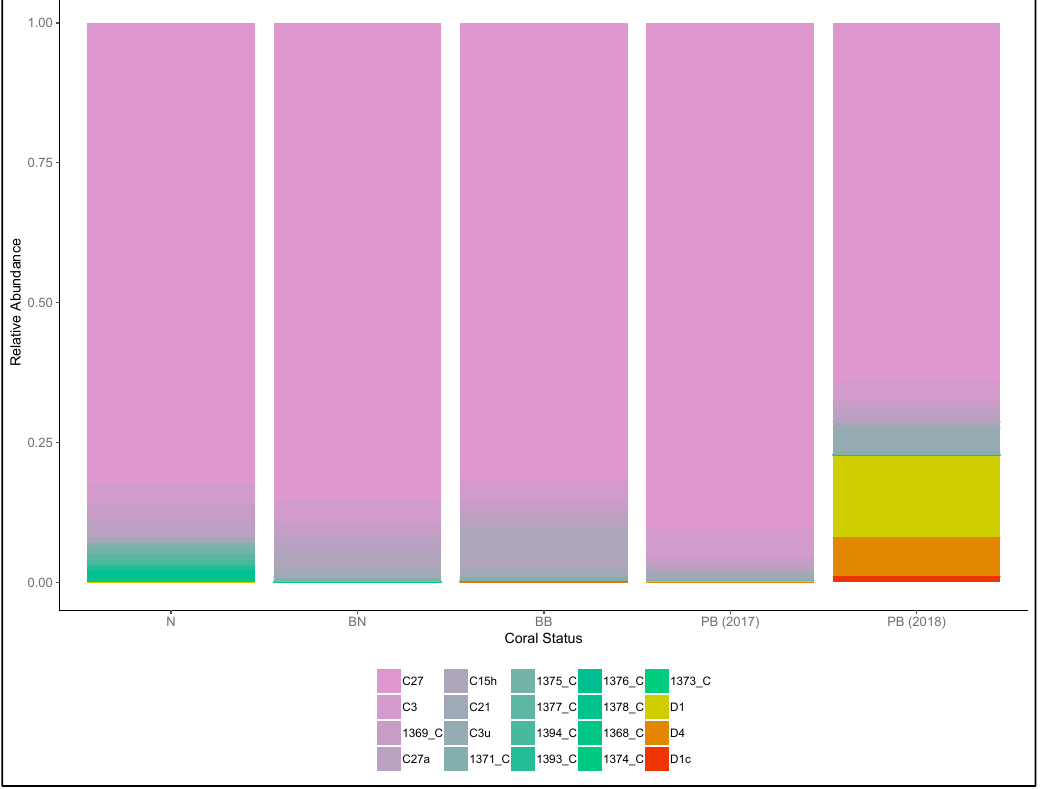
Figure 3. Diversity and relative abundances of Symbiodiniaceae types among the five different coral groups (N: normal colonies in 2016, BN: normal portions of the bleached colonies in 2016, BB: bleached portions of the bleached colonies in 2016, PB (2017): post-bleaching colonies in 2017, PB (2018): post-bleaching colonies in 2018).